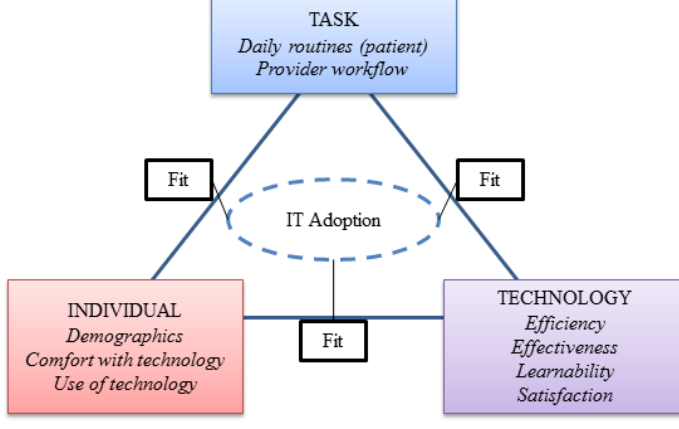
Figure 1. A diagram of the FITT Framework to assess usability and feasibility. Adapted from Sheehan et al [27] p.